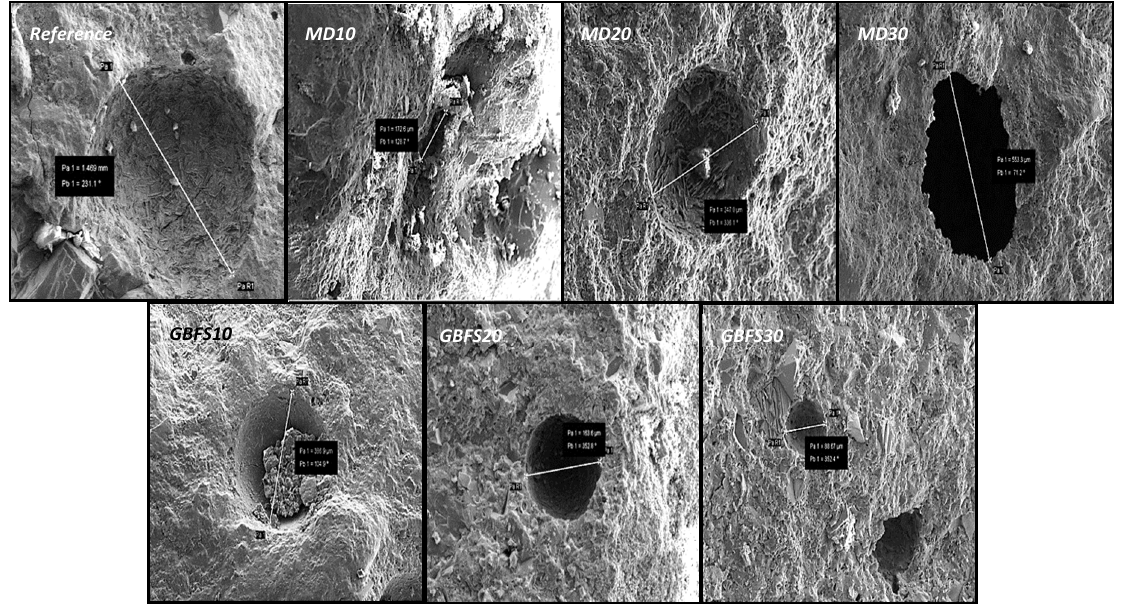
Figure 10. The pore structure of the SCC mixtures.